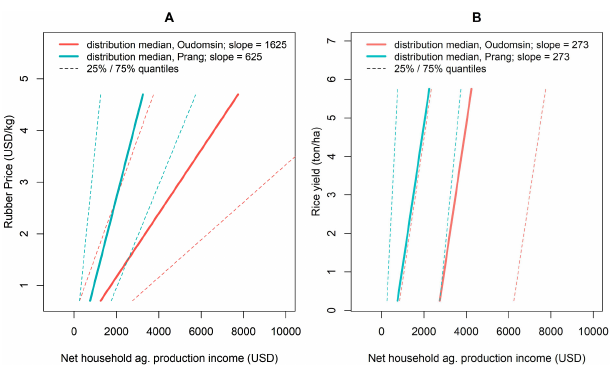
Fig. 5 . Sensitivity of net agricultural production income of an average Oudomsin and Prang household with zero leased paddy hectares to (A) rubber market price in China and (B) paddy rice yield. The solid line indicates median income (slopes indicated). The dashed lines indicate the 25% and 75%